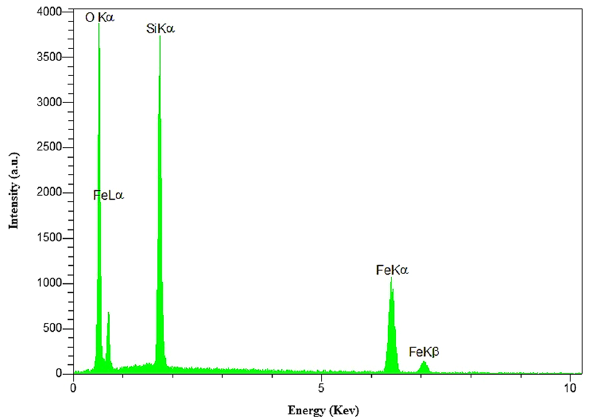
Figure 9. EDS analysis of Fe 3 O 4 @Void@m.SiO 2 nanomaterial before adsorption process.